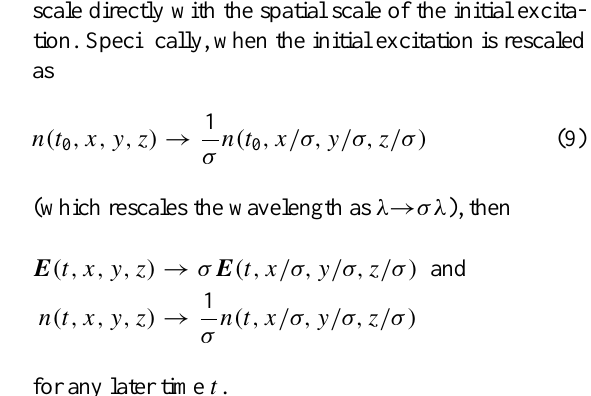
Fig. 6. log 2 -log 2 plots of the peak electric field versus wavelength, Figure 6: log 2 -log 2 plots of the peak electric field versus as determined by the scaling rule of Sect. 2.1 (theory), and by the wavelength, as determined by the scaling rule of Section 2.1 (theory), and by the simulations presented in Figures 2 simulations presented in Figs. 2 through 5. The horizontal axis is through 5. The horizontal axis is log 2 of wavelength in km, log 2 of wavelength in km, and the vertical axis is log 2 of electric and the vertical axis is log 2 of electric field in mV/m. The field in mV/m. The scaling rule is applied by setting the theoretical scaling rule is applied by setting the theoretical and simu- and simulated electric field equal at λ = 25km, and scaling to the lated electric field equal at λ = 25 km, and scaling to the longer longer wavelengths.